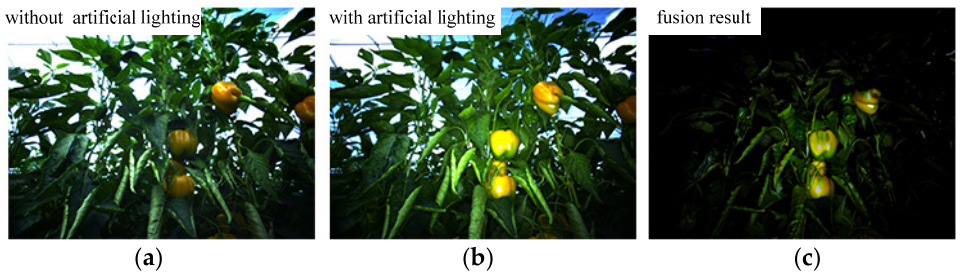
Figure 3. Color correction from images with/without artificial lighting (Photo: Reprinted with permission from Ref. [48]. 2019, Arad B.). ( a ) Image without artificial lighting; ( b ) Image with artificial lighting; and ( c ) Image after color correction.